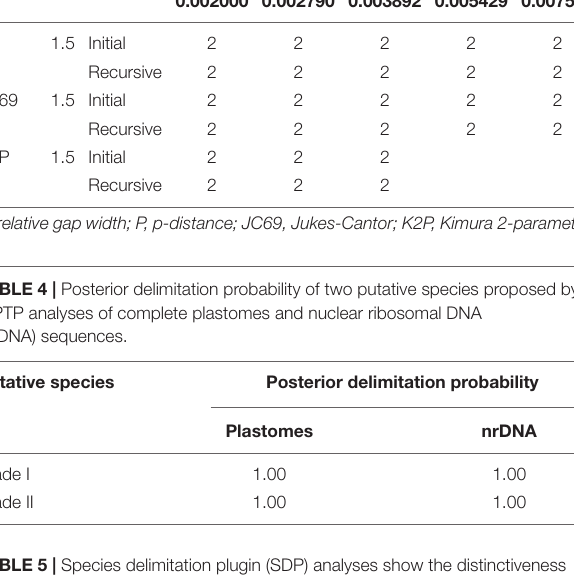
TABLE 5 | Species delimitation plugin (SDP) analyses show the distinctiveness [Rodrigo’s P ( RD ) ] and significance [Rosenberg’s P ( AB ) ] of the two clades recovered by phylogenetic analyses of complete plastomes and nuclear ribosomal DNA (nrDNA) as species-level taxonomic units. Phylogenetic